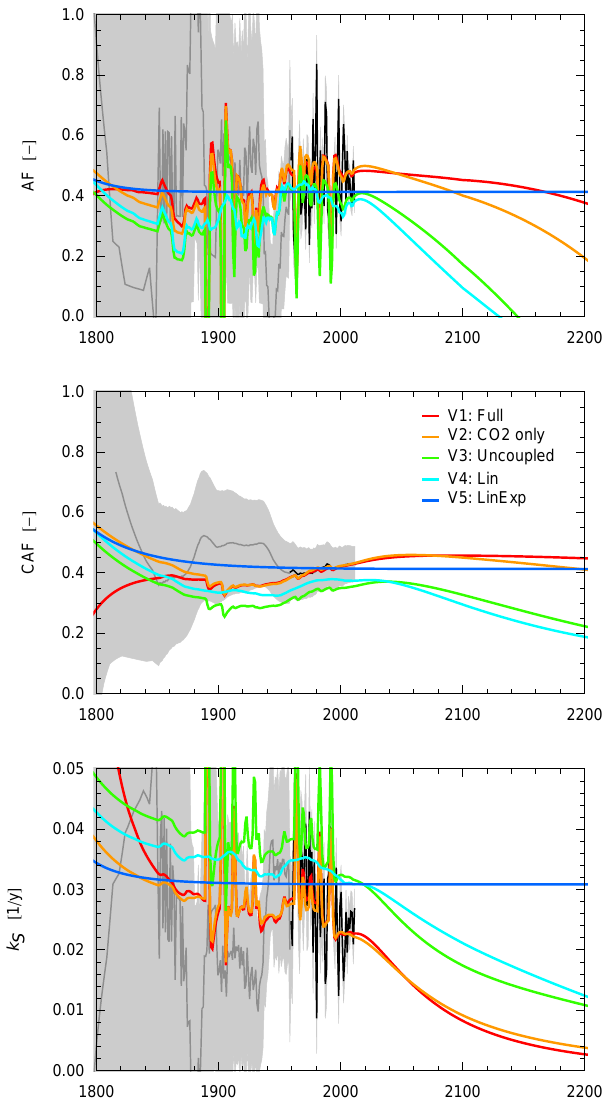
Fig. 9. SCCM predictions of AF, CAF and k S with successive sim- plification of process descriptions, from a full model to the LinExp idealisation. Model details as for Fig. 8. Error bands on observations are ± 1 σ . Data sources: Appendix